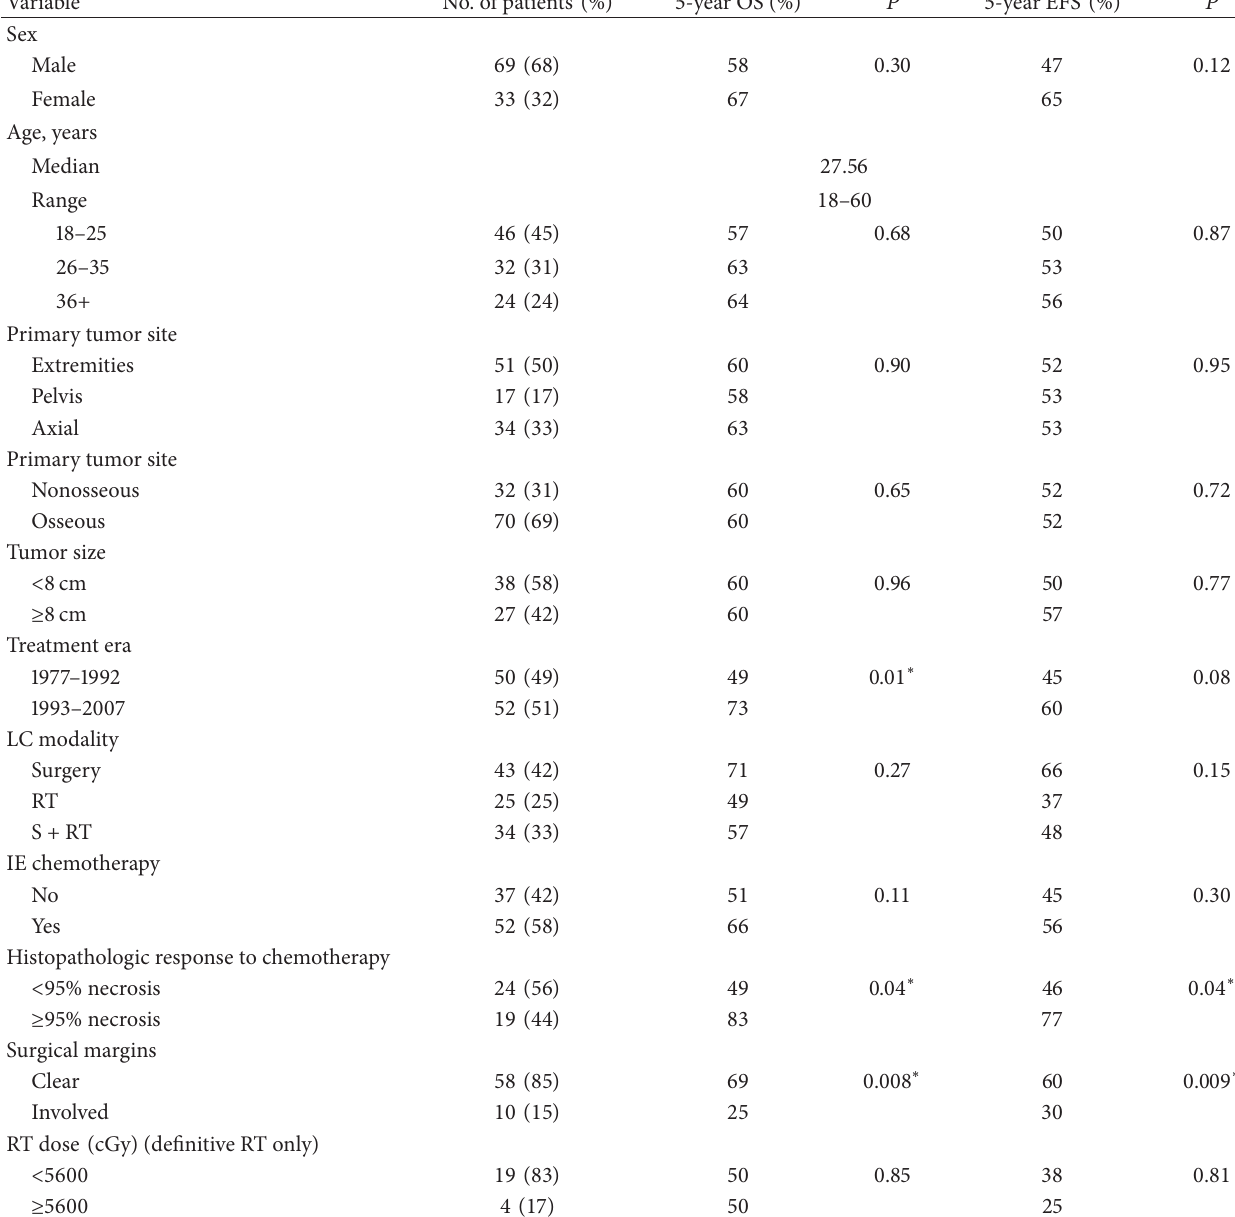
Table 1: Patient characteristics and univariate analysis for overall (OS) and event-free survival (EFS) ( 𝑛 = 102 ).